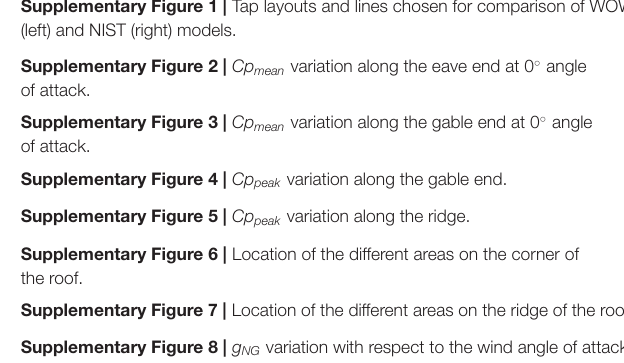
Supplementary Figure 1 | Tap layouts and lines chosen for comparison of WOW (left) and NIST (right) models. Supplementary Figure 2 | Cp mean variation along the eave end at 0 ◦ angle of attack. Supplementary Figure 3 | Cp mean variation along the gable end at 0 ◦ angle of attack. Supplementary Figure 4 | Cp peak variation along the gable end. Supplementary Figure 5 | Cp peak variation along the ridge. Supplementary Figure 6 | Location of the different areas on the corner of the roof. Supplementary Figure 7 | Location of the different areas on the ridge of the roof. Supplementary Figure 8 | g NG variation with respect to the wind angle of